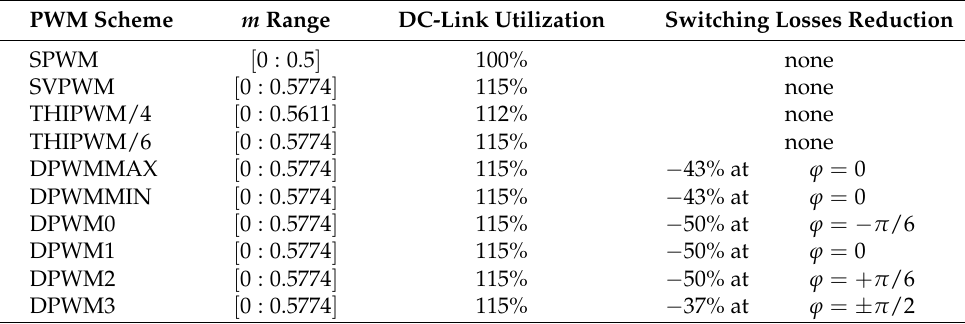
Table 1. Popular PWM common-mode injections and their main